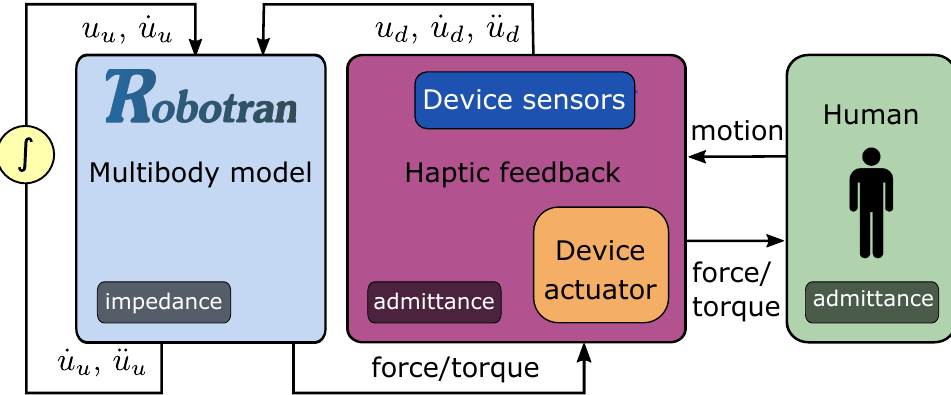
Figure 7. HIL haptic principle with ROBOTRAN. The light blue box, in this case, corresponds to the Direct Dynamics of Figure